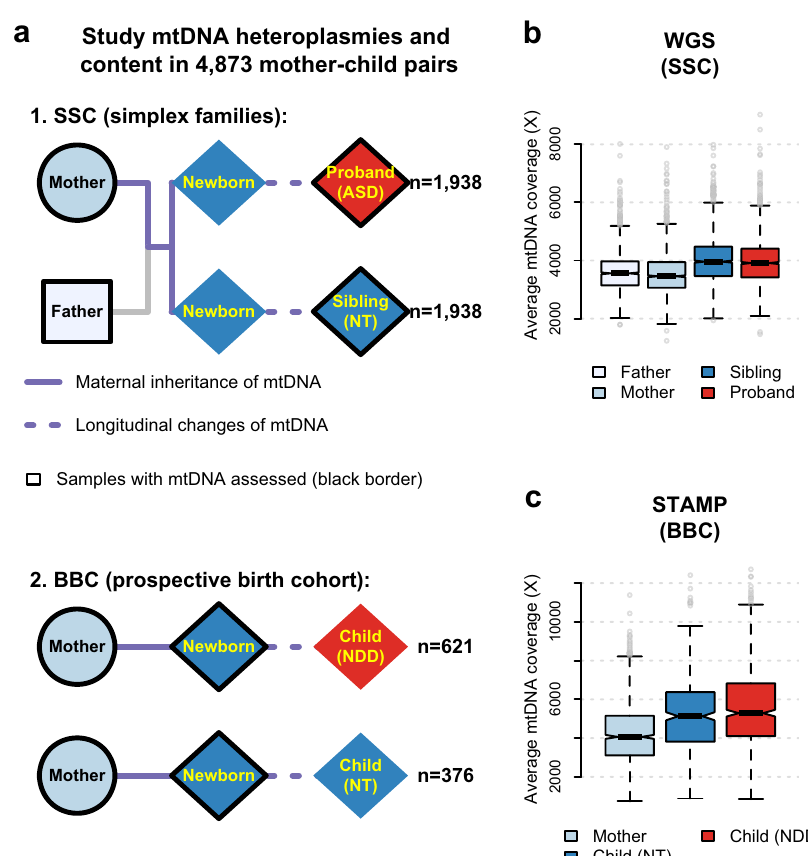
Fig. 1 Study design and mtDNA evaluation in the SSC and BBC. a A schematic diagram of families (mother, father, sibling, and proband with ASD) in the SSC ( n = 1938) and mother-child dyads in the BBC ( n = 997). The square, circle, and diamond represent male, female, and both sexes, respectively. For both the SSC and BBC, the inter-generational transmission of mtDNA is represented by solid lines and the individual child longitudinal change in mtDNA is illustrated by dotted lines. b , c Box plots for the average mtDNA sequencing coverage among 1938 families in the SSC (as illustrated in a ) using whole- genome sequencing (WGS) ( b ), and among 997 dyads of mothers and children in the BBC (as illustrated in a ) using mtDNA-targeted sequencing (STAMP) ( c ). Box plots in b and c show the median as the center line, 95% con fi dence interval of the median as the notch, the fi rst (Q1) and third (Q3) quartiles as the boundaries of the box, the values of the largest and smallest data points within the range between Q1 – 1.5× interquartile range (IQR) and Q3 + 1.5× IQR as the boundaries of the whiskers, and the outliers beyond this range as the gray points. ASD: autism spectrum disorder; NT: neurotypical; NDD: neurodevelopmental compared to their siblings (OR = 1.51, P = 0.0012) and parents mutations 6 near ASD risk genes 3 , in the nuclear genome (OR ≥ 1.51, P ≤ 0.0026, Fig. 2b and Supplementary Fig. 1). The (Supplementary Table 3). The association between PP hetero- plasmies and ASD was further strengthened after adjustment for ASD-associated nuclear variants in the SSC (OR = 1.59; (versus siblings: OR = 2.15, P = 0.0012; versus parents: OR ≥ 2.20, P ≤ 0.00025; Fig. 2b). PP heteroplasmies affecting OXPHOS genes (OR = 1.50, P = 0.0083) and RNA genes (OR = 1.62, P = 0.041) were both signi fi cantly associated with ASD (Fig. 2d,